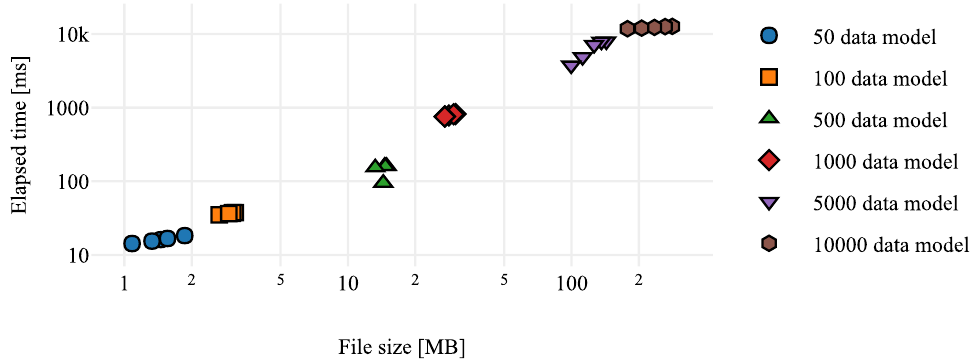
Figure 10. The relation between different Data Model file sizes and the elapsed execution time (the axes are in logarithmic scale).